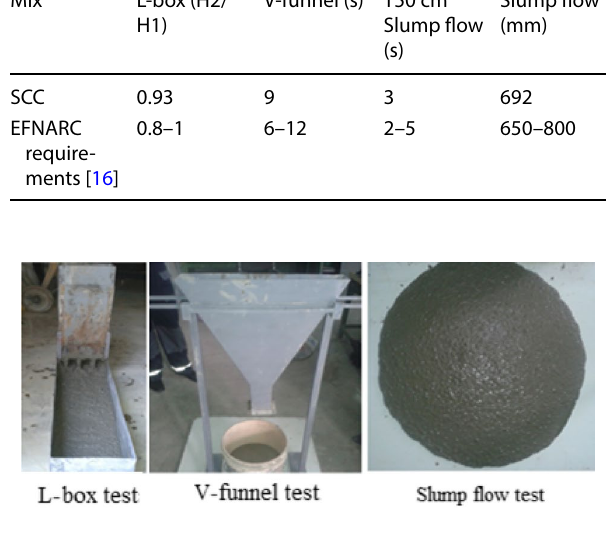
Fig. 1 a Layout of the hollow-core concrete beams. b Cross-sec- tions of the solid beam (B1) and hollow-core concrete beams (B2 to B6). c Side-view in one of the hollow-core beams